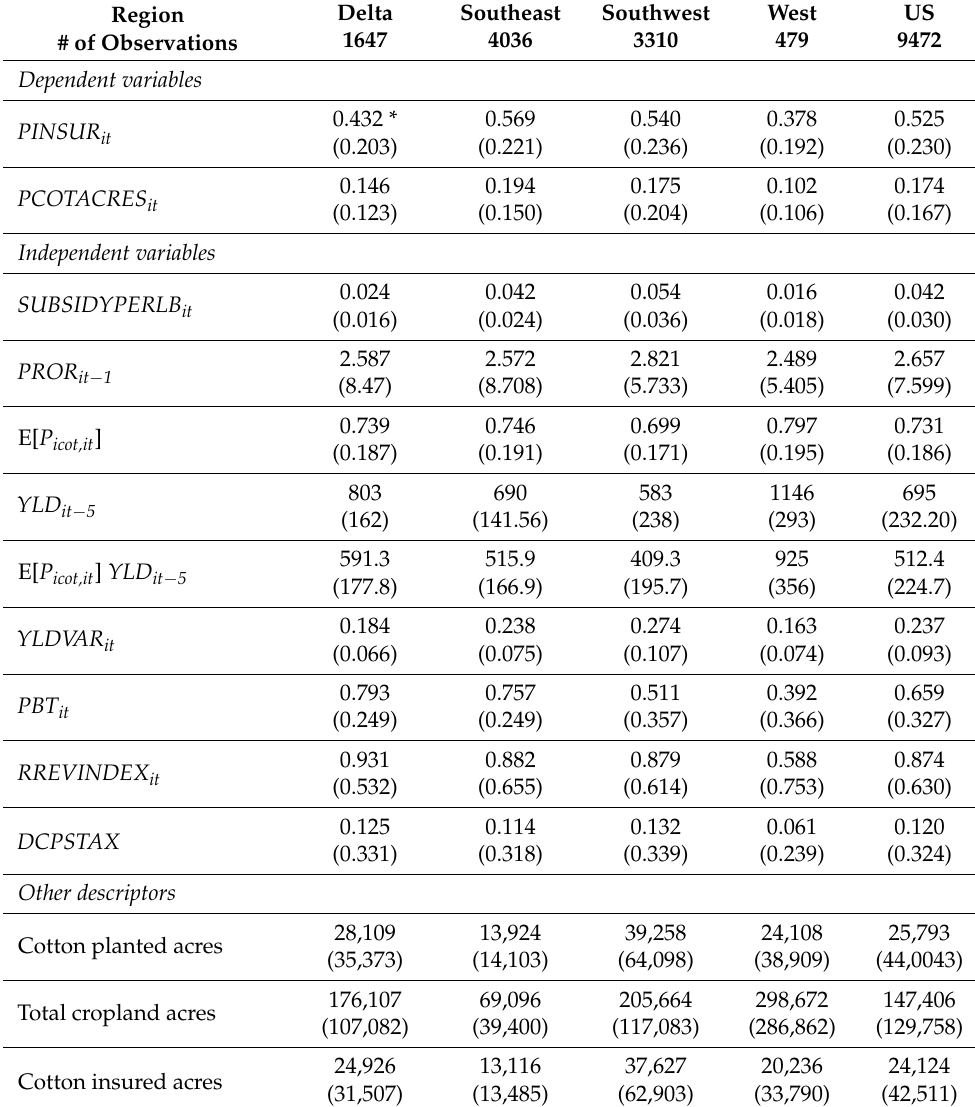
Table 1. US and regional county summary